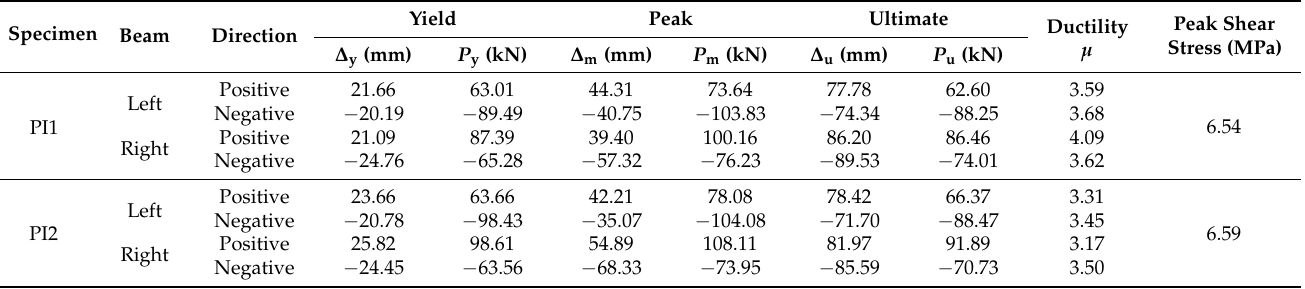
Table 5. Summary of test